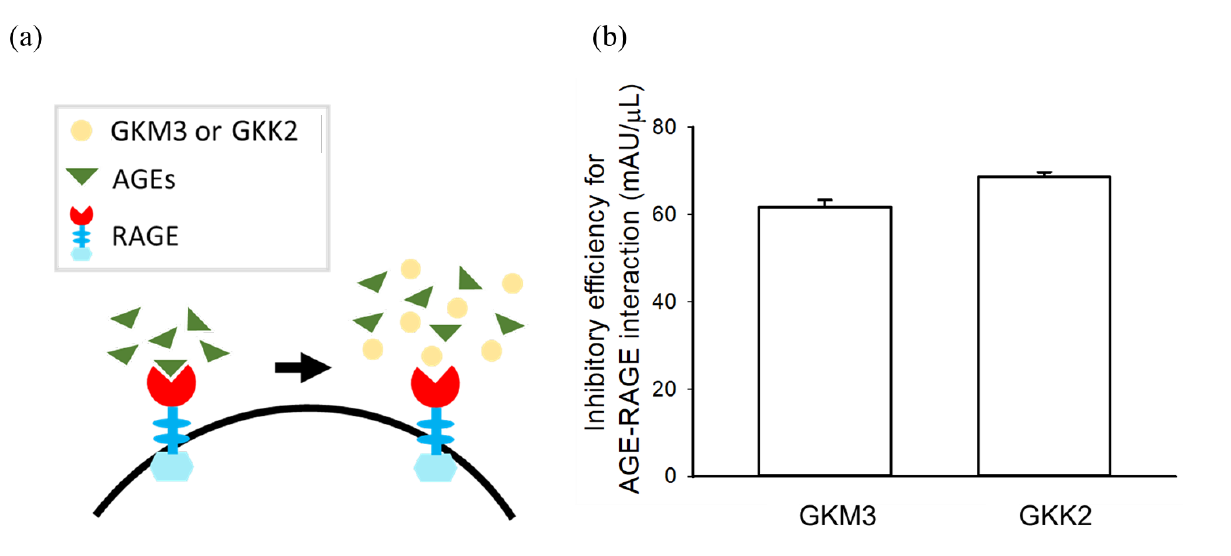
Figure 8. Effect of GKM3 and GKK2 on the ligation of RAGE with glycated proteins. ( a ) Scheme of inhibition of glycated proteins–RAGE ligation by GKM3 and GKK2 and ( b ) the experimental data. Data shown are means of results obtained from three independent experiments. RAGE: receptor for advanced glycation end products; AGE: advanced glycation end products.